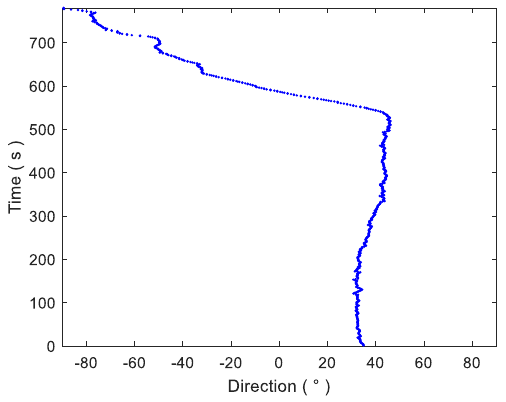
Figure 13. GPS direction information of target ship.